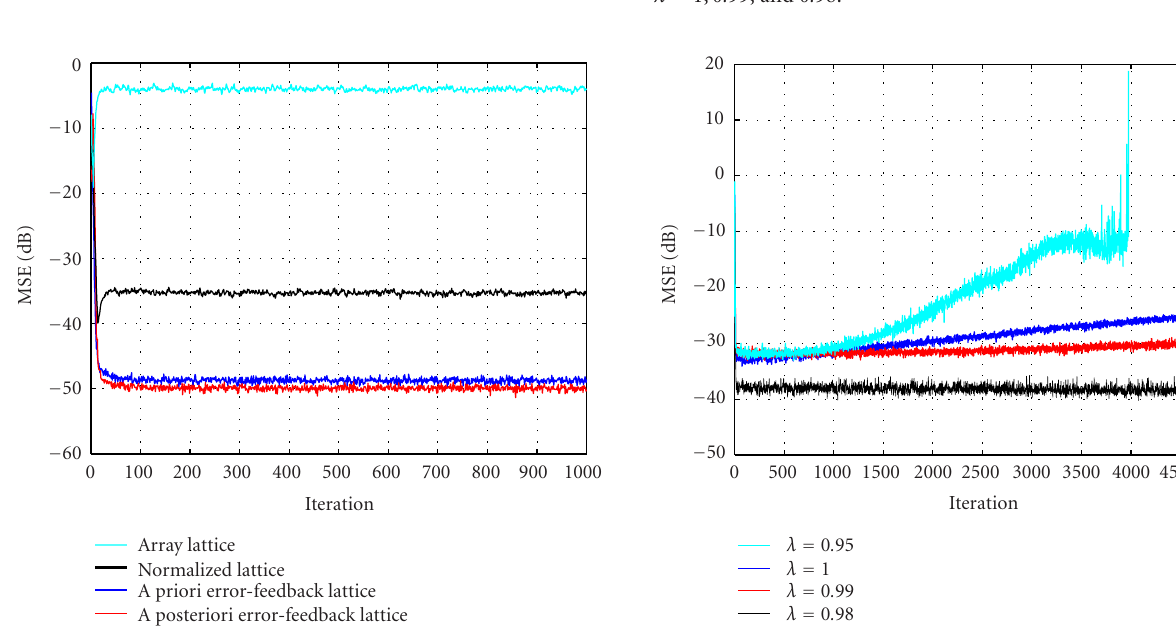
Figure 5: A priori error-feedback algorithm for di ff erent values of λ = 1,0 . 99, and 0 . 98.